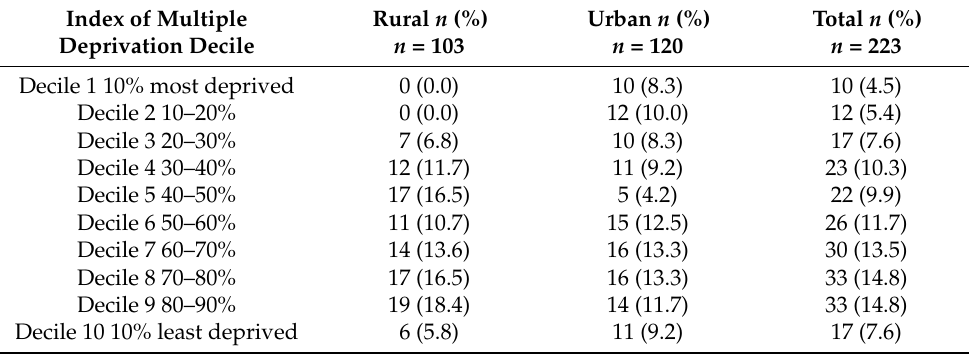
Table 2. IMD decile scores for rural and urban